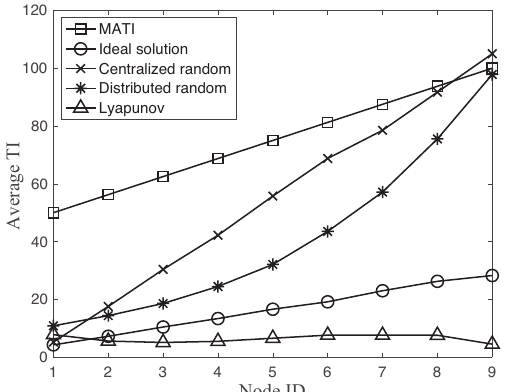
Figure 8. MATI requirement and average TI of each node using different transmission scheduling schemes with N = 9.